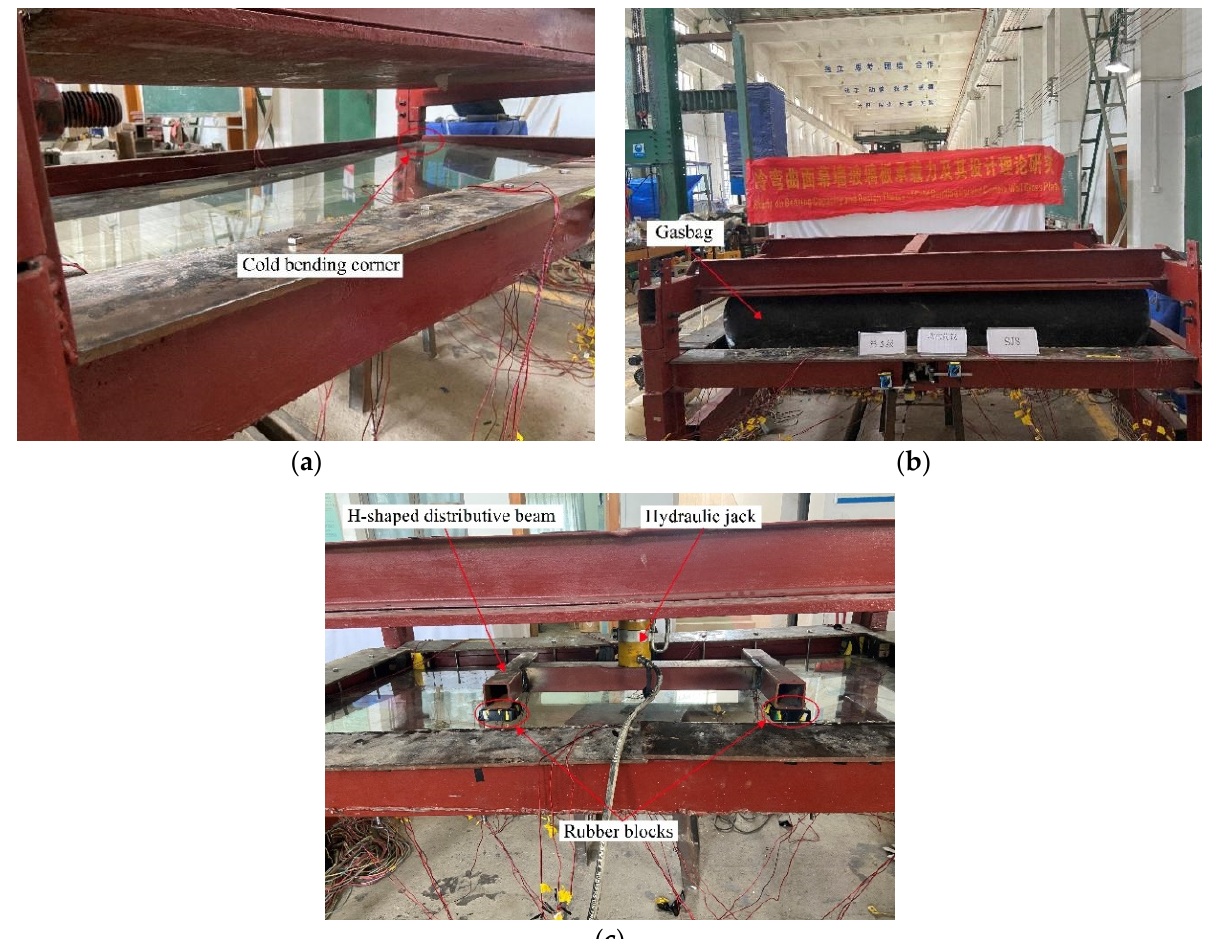
Figure 2. Test device. The symbols in the figure are as follows: ( 1 ) Reaction frame, ( 2 ) Fixed steel plates, ( 3 ) Glass, ( 4 ) Support frame, ( 5 ) Square steel pipe, ( 6 ) Screw, ( 7 ) Fixed buckle.